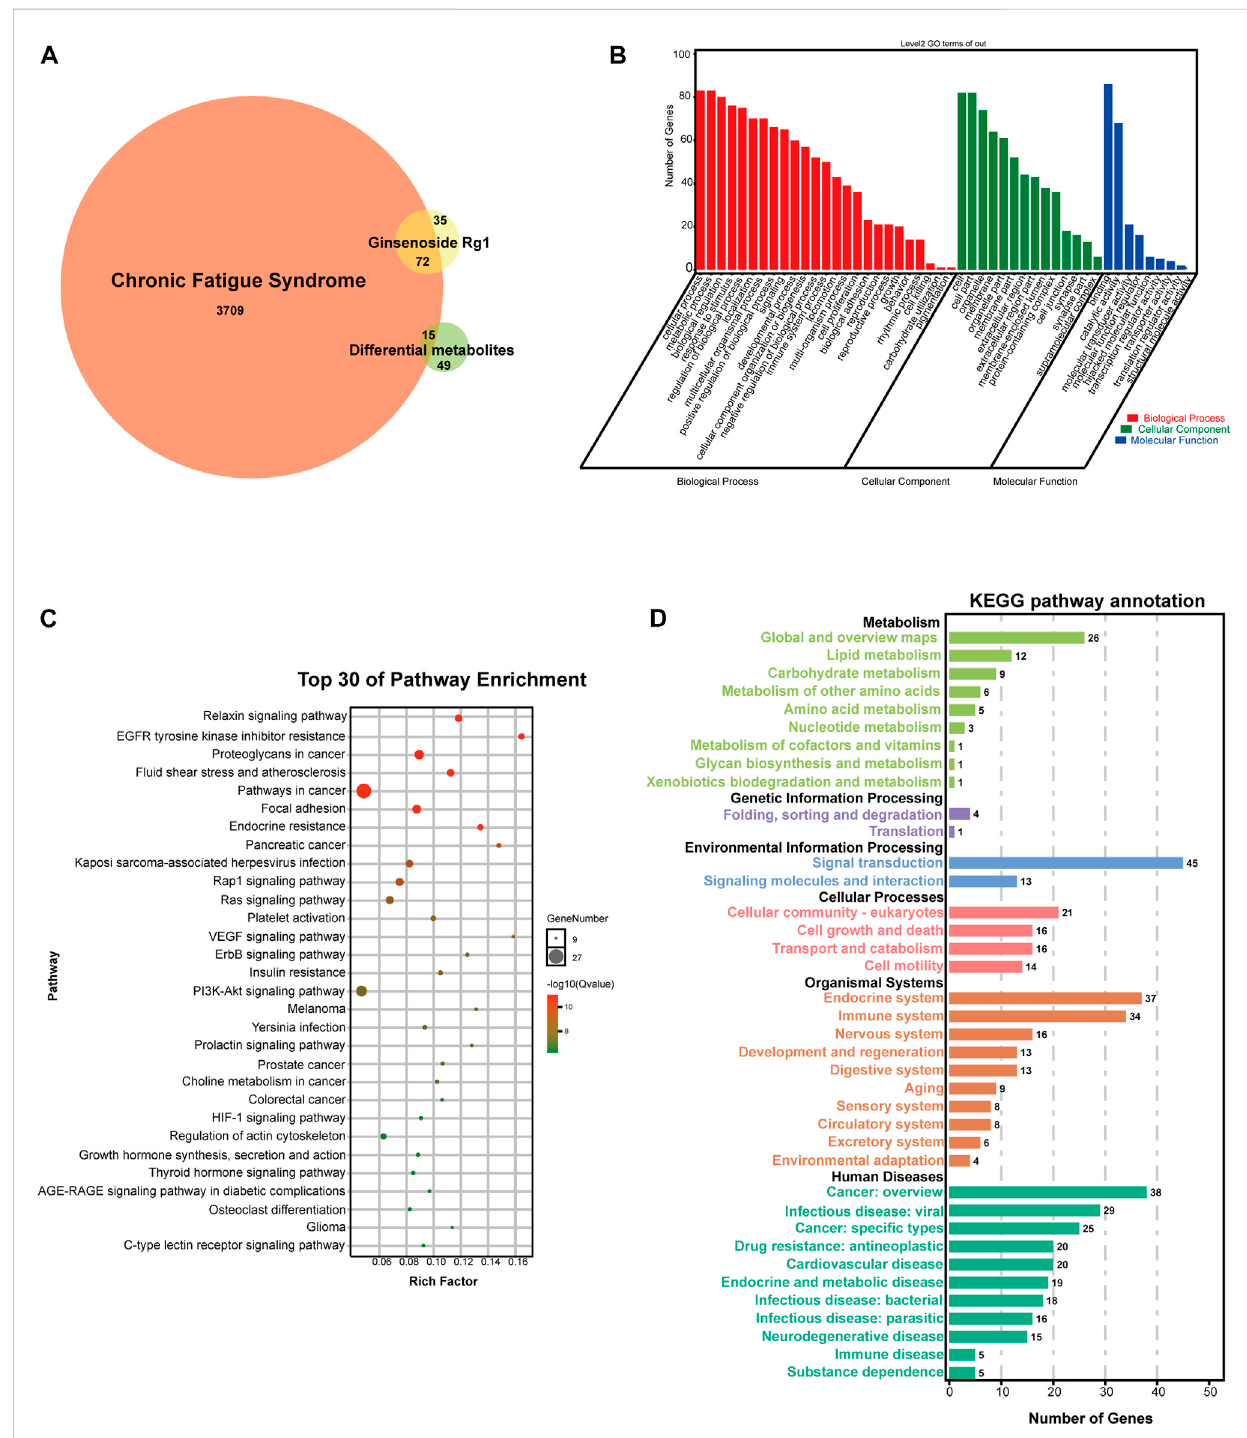
FIGURE 7 Network analysis of potential targets. (A) VENN diagram of potential targets. (B) GO analysis of potential targets. (C) KEGG pathway enrichment analysis of potential targets. (D) KEGG pathway annotation of potential